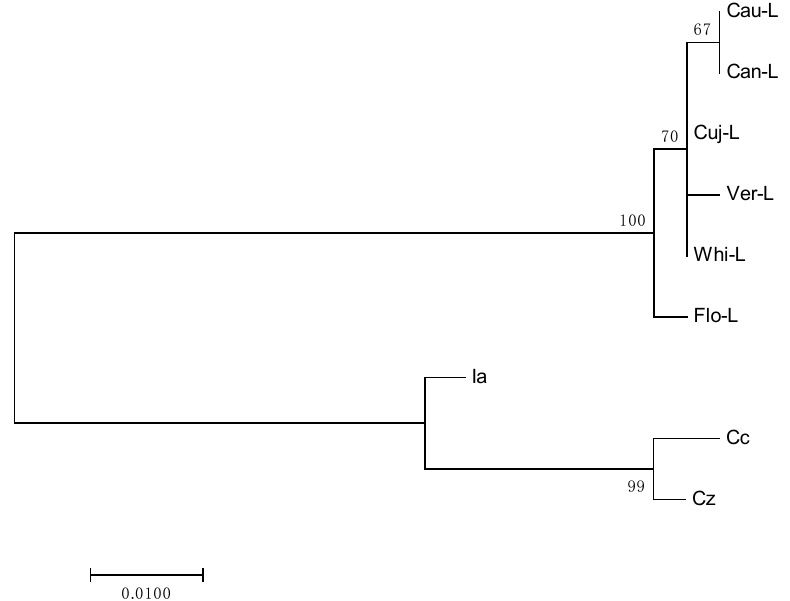
Figure 3. Molecular Phylogenetic analysis by Maximum Likelihood method for matK sequence of species of Lauraceae and Calycanthaceae (Outgroup).